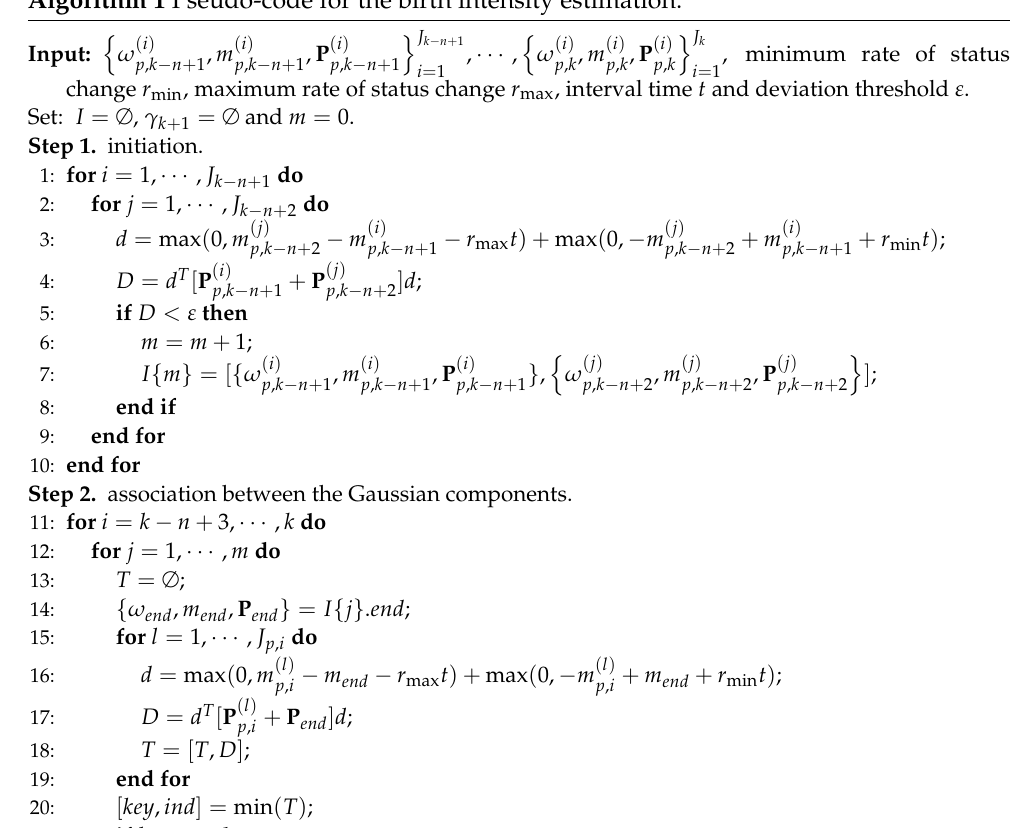
Algorithm 1 Pseudo-code for the birth intensity